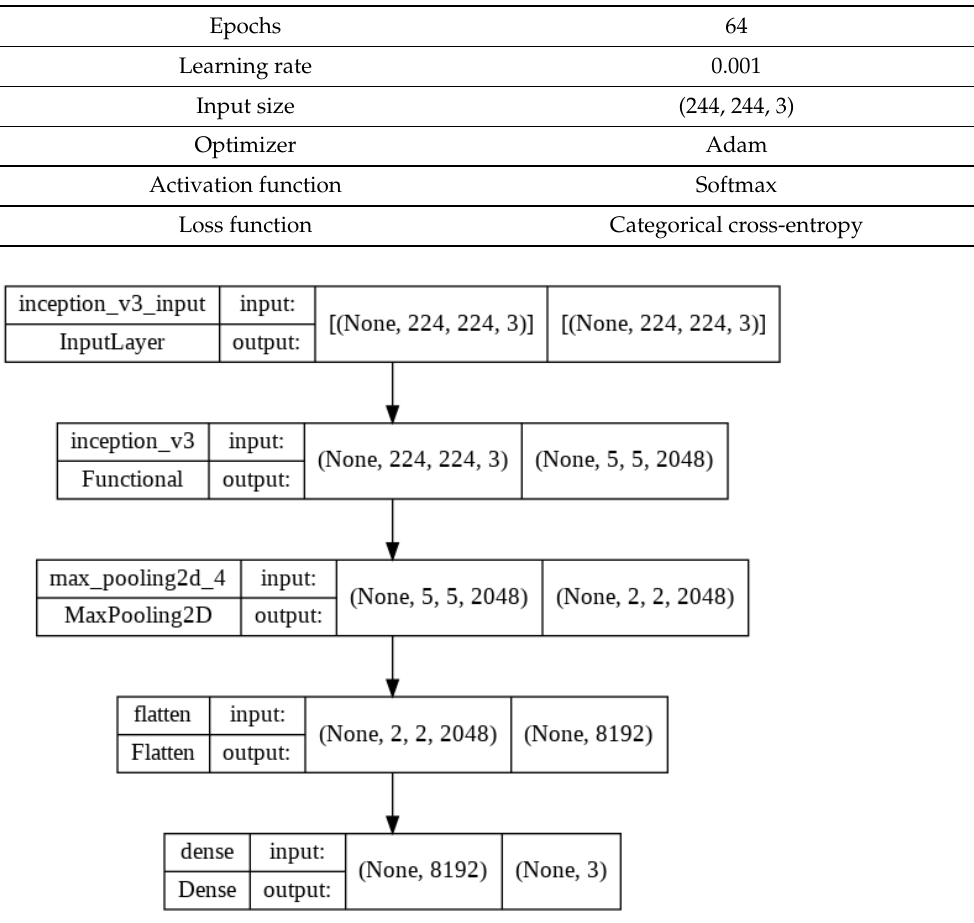
Figure 3. CNN architecture for air tire pressure